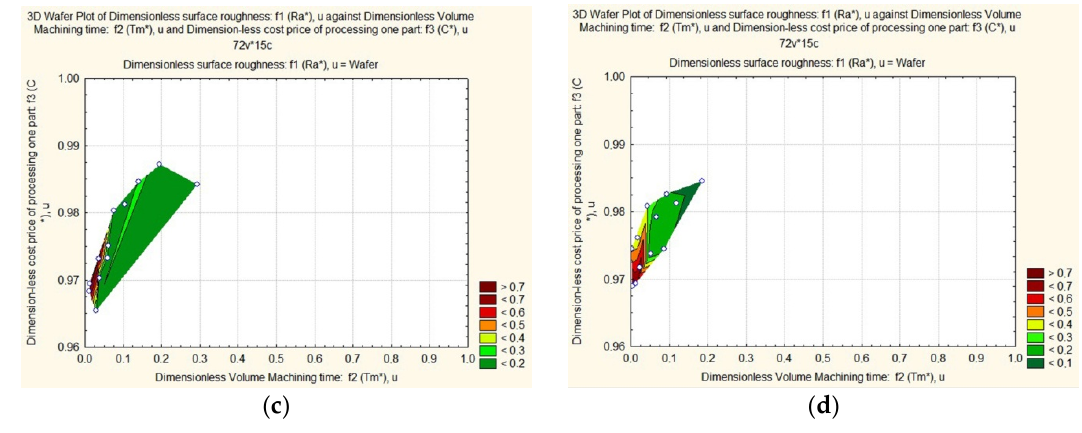
Figure 11. Surface projections of Ra * values depending on the change in the values of С * and T m * at a fixed depth of cut (ECAP-6 hardening of an AA6061 alloy workpiece): ( a ) a p = 0.1 mm; ( b ) a p = 0.2 mm; ( c ) a p = 0.3 mm; ( d ) a p = 0.4 mm.